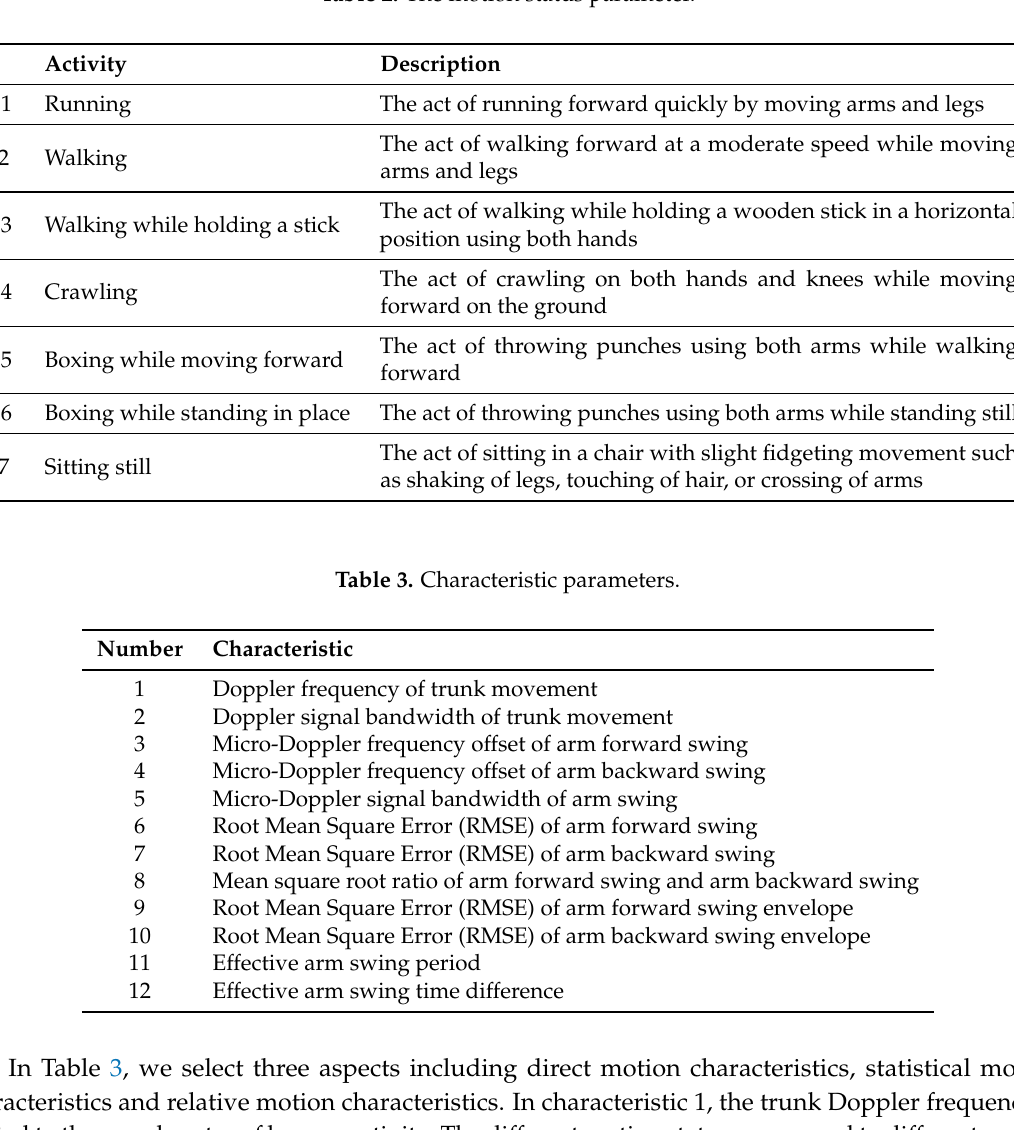
Table 2. The motion status parameter.